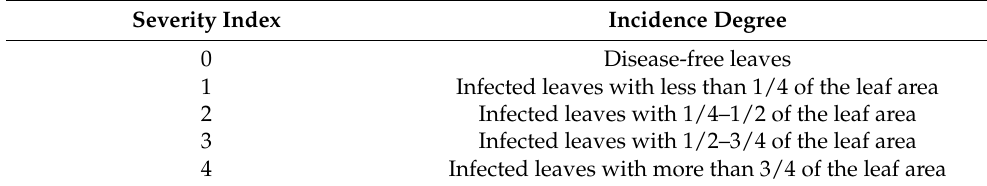
Table 1. Statistical method of disease grade in the diseased seedlings.